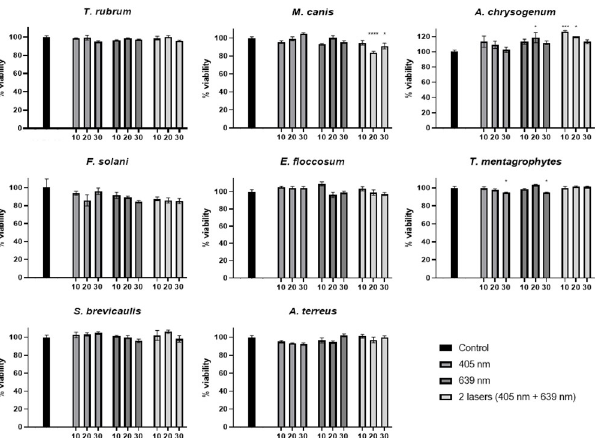
Fig 2. Percentage of viability for each of the eight fungal species with laser treatments using only 405 nm, only 639 nm and both lasers combined at three different times (10 min, 20 min and 30 min). Statistical significant results are shown in comparison with the absolute control and indicated with asterisk.